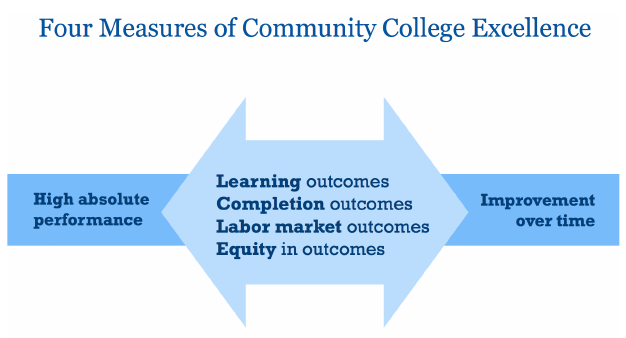
Figure 1. Aspen Institute's Model for the Measures of Community College Excellence (2014b)